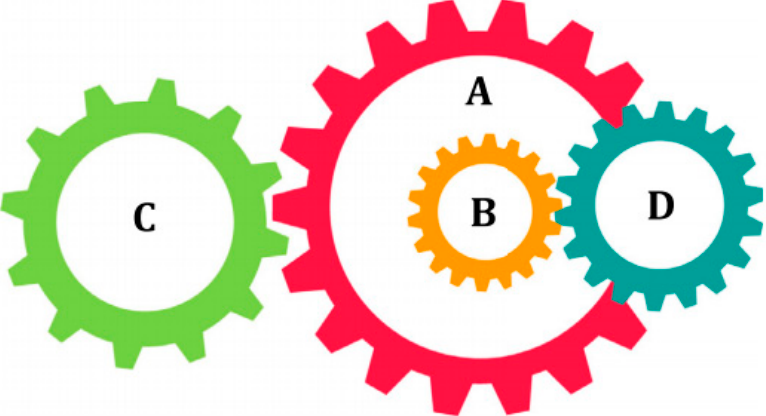
Figure 10. Sketch map of the gear train design problem [55]. Table 8. Evaluation indicators and variable values for Figure